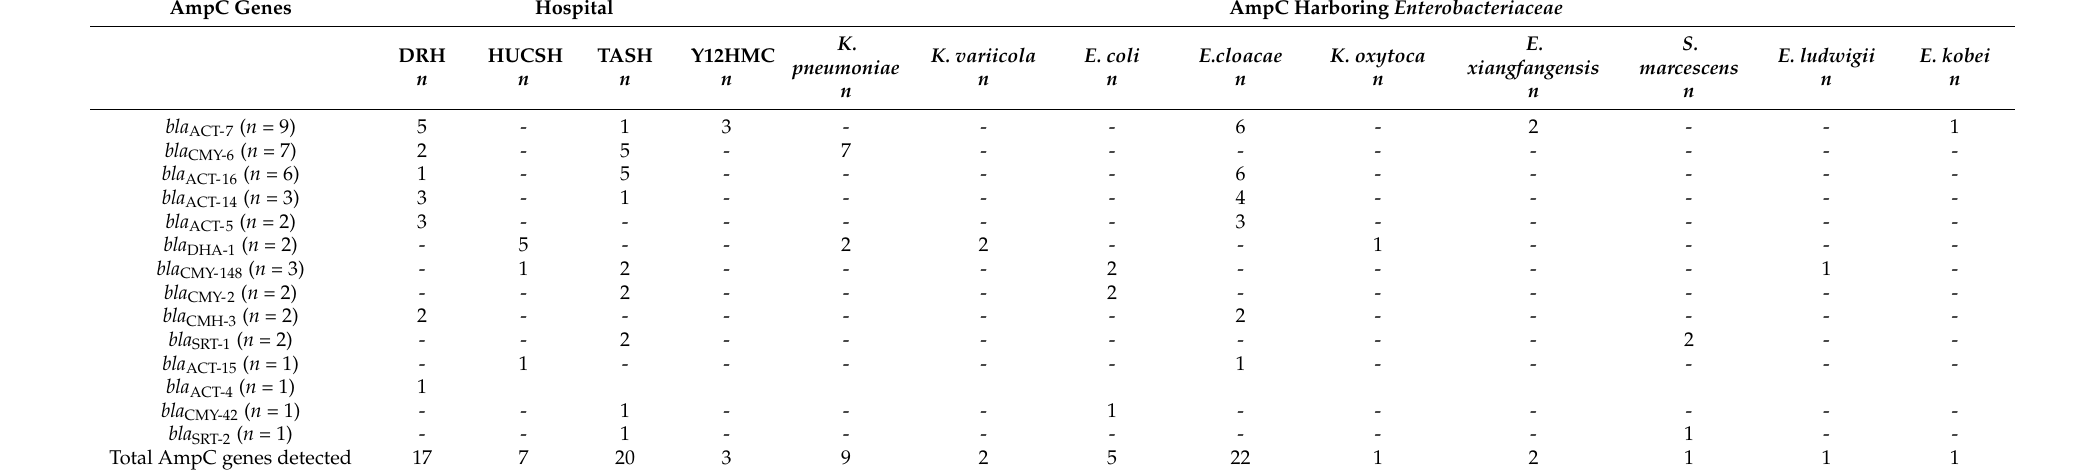
Table 7. Frequency and distribution of the AmpC genes detected at four Ethiopian